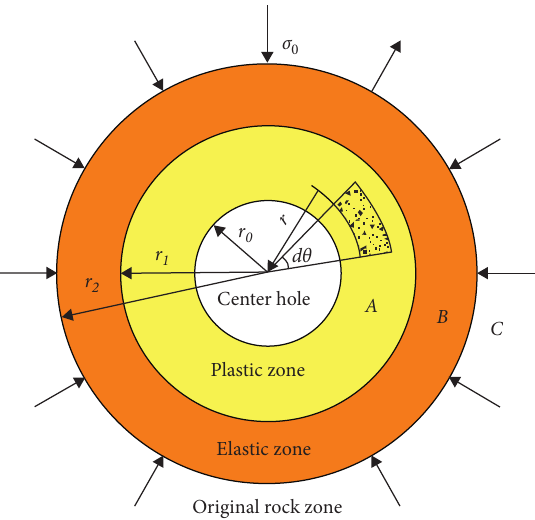
Figure 3: Elastic and plastic zones in the rock surrounding the drill